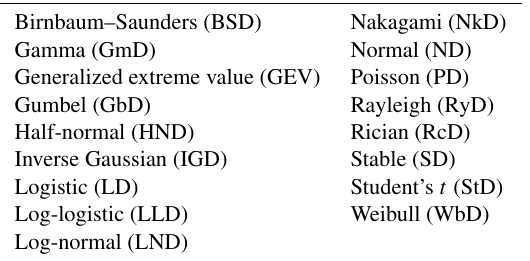
Table A1. List of the tested and suitable PDFs preset in the MAT- LAB statistical toolbox (the short acronyms in brackets are for fur- ther